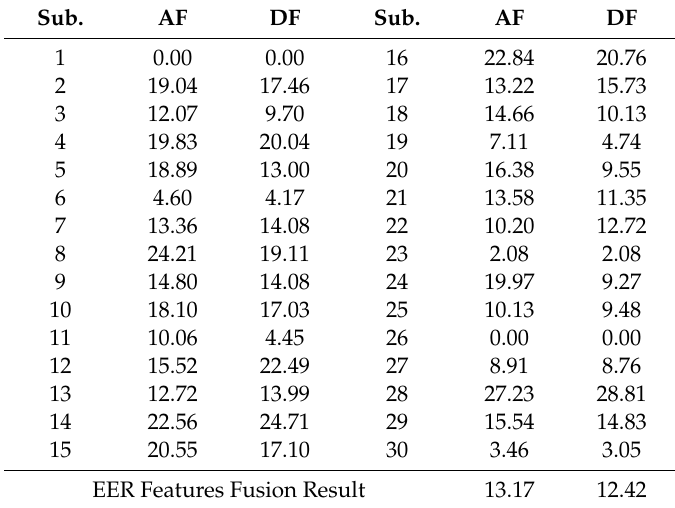
Table 4. Showing feature fusion classification comparison in ERR (%).